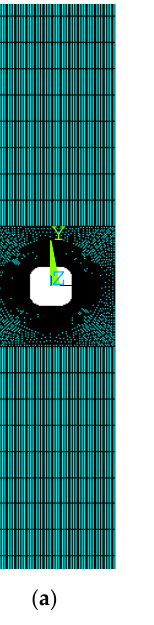
Figure 21. Finite element mesh: ( a ) general view; ( b ) enlargement of the notch and circular overlay area.